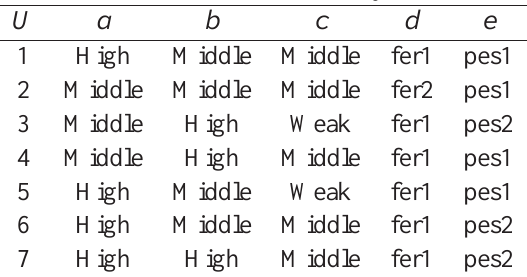
Table 2: An information system